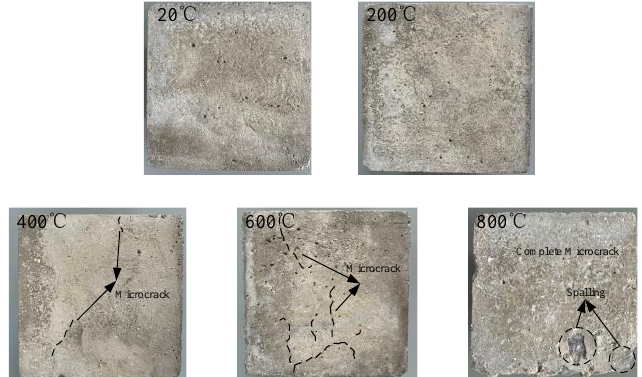
Figure 3. Concrete surface damage morphology after high temperature and rapid cooling.